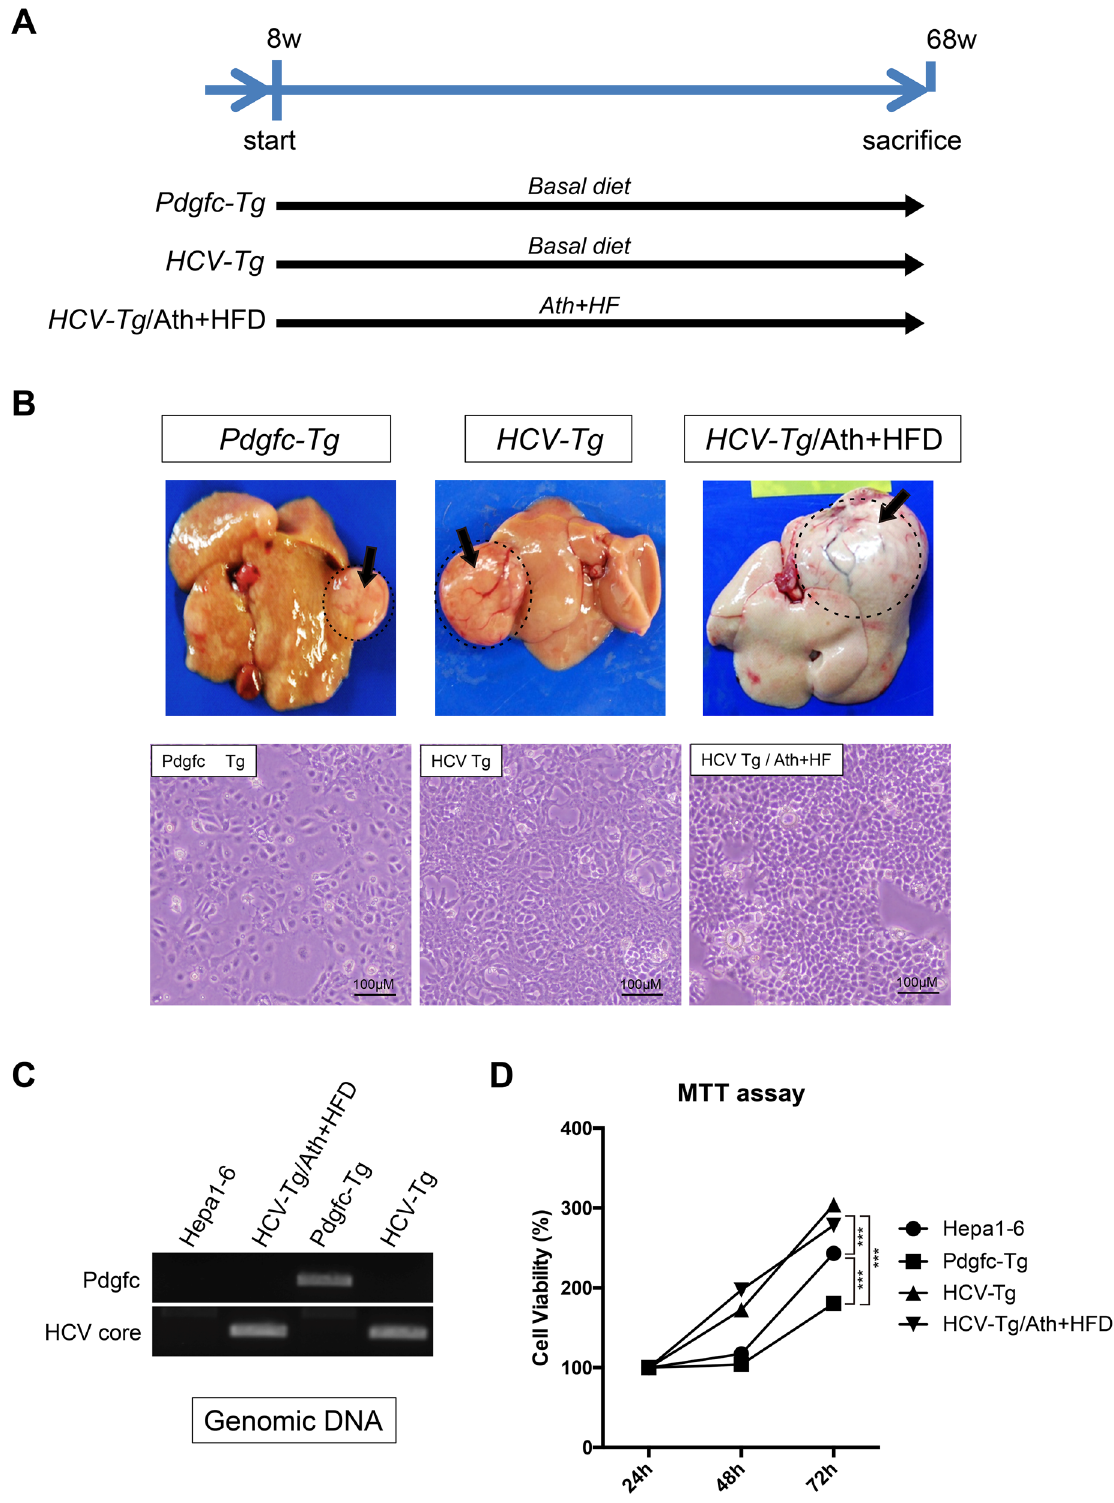
Figure 1. Establishment of liver tumor cell lines derived from Pdgfc-Tg, HCV-Tg, and HCV-Tg/Ath + HFD mice . ( A ) Feeding schedule of each group of mice. ( B ) Developed liver tumors in Pdgfc-Tg, HCV-Tg, and HCV-Tg/Ath + HFD mice (upper), and established cell lines from each tumor (lower). ( C ) PCR amplification of the integrated genes ( Pdgfc and HCV). Full-length agarose gels are presented in Supplemental Fig. 1. ( D ) MTT assay of each cell line derived from Pdgfc-Tg, HCV-Tg, and HCV-Tg/Ath + HFD mice and the Hepa1-6 cell